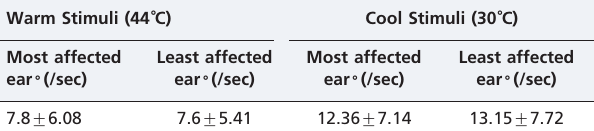
Table 1 - Mean values of the maximum slow-phase velocity in both ears of patients in Group B.